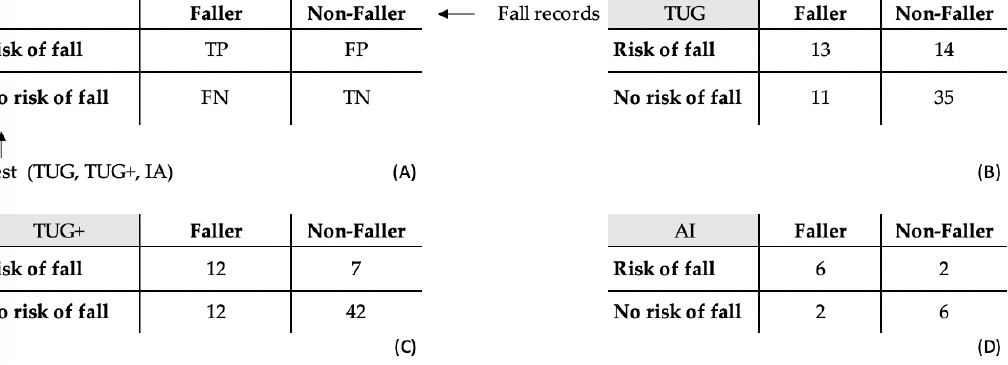
Figure 5. ( A ) ROC curve for TUG test. An area under the curve of 0.621 is obtained, a Youden’s J of 0.256 and a threshold of 22.5 s. ( B ) TUG + test classification algorithm.